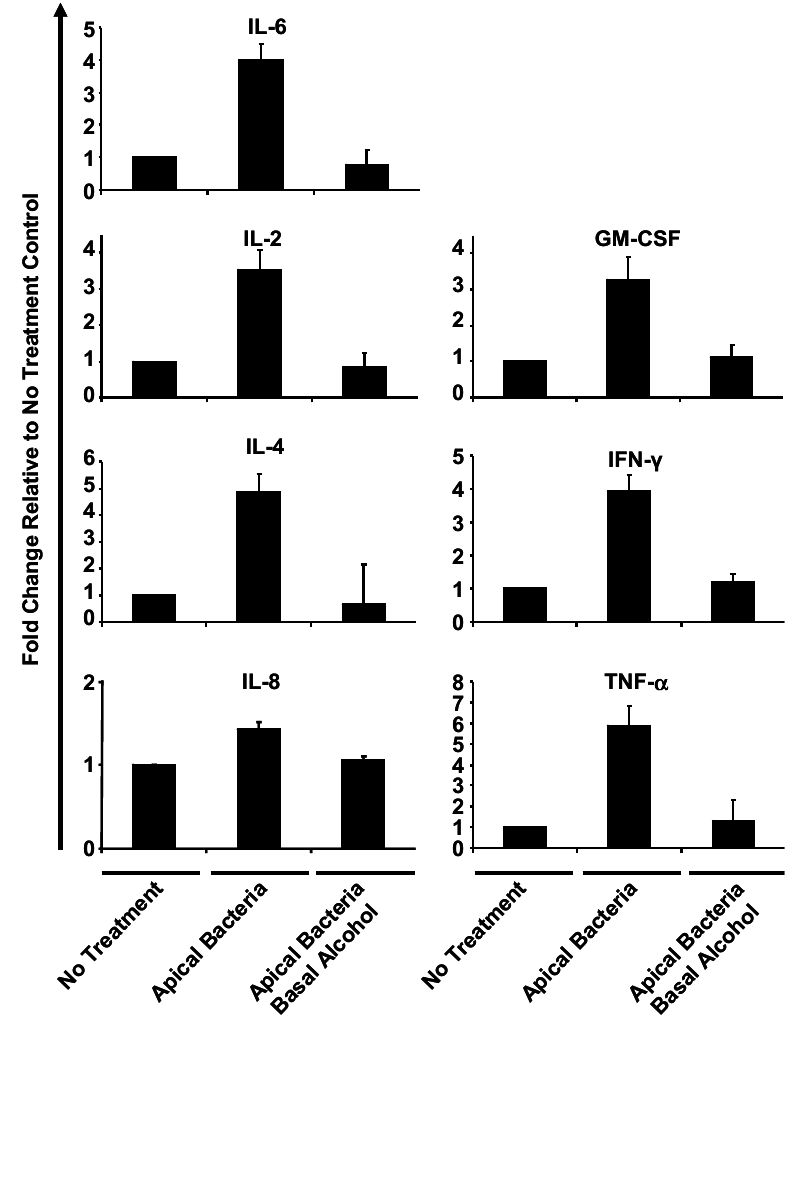
cytokines. Alcohol application significantly inhibited the response on all three cytokines. The suppressive effects of alcohol on IL-6 and TNF- α were attenuated by adenosine and NECA. Neither agent had any effect on MCP-1. Figure 5. Alcohol effect on epithelial basolateral cytokine release under apical bacterial challenge. NHBE cells were grown at the air-liquid interface and challenged with live K. pneumonia apically in the presence (50 mM) or absence (0 mM) of basolateral alcohol for 24 h. Eight different cytokines in the basolateral media were estimated by cytokine Bio-plex assay. Data are expressed as fold changes as compared to the base levels of cytokines secreted by the no treatment control. The absolute amount of the base level of each cytokine is presented in Table